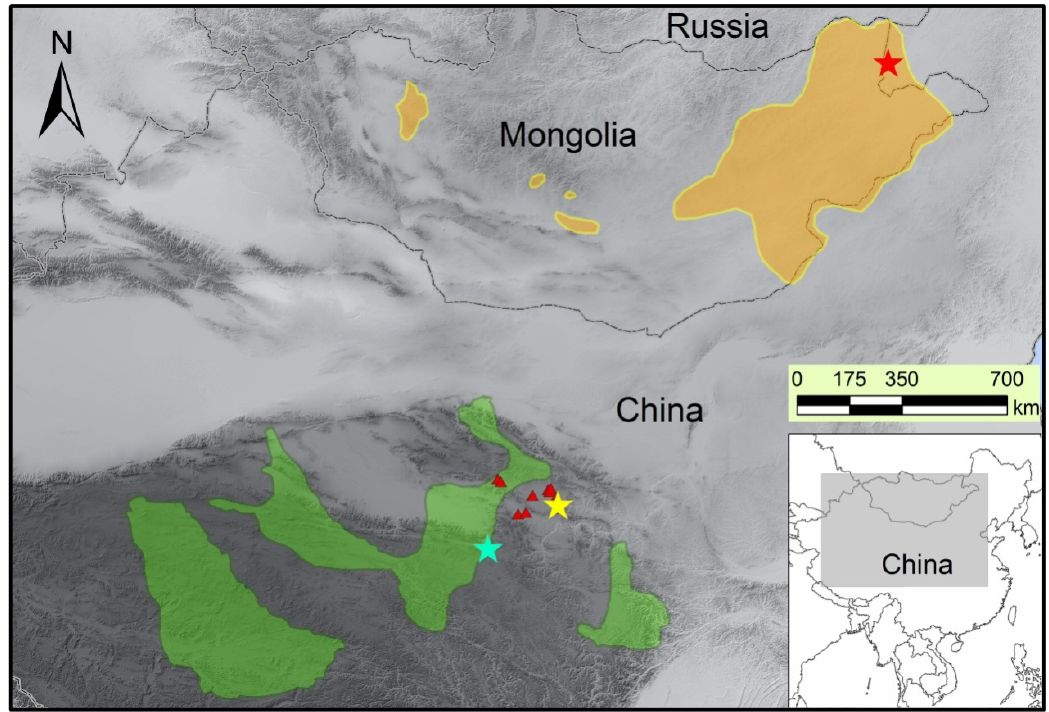
The green area represents the distribution range of P. picticaudata and the orange area represents the distribution of P. gutturosa . The red triangles represent the scattered distributed patches of P. przewalskii . The blue, red and yellow pentagrams indicate sampling locations of P. picticaudata , P. gutturosa and P. przewalskii, respectively. The shaded rectangle on the inset indicates the location of the main map in